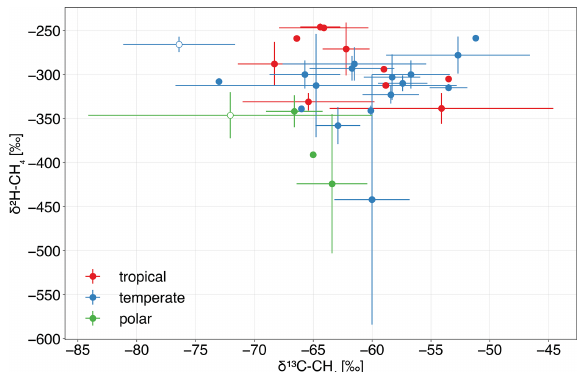
and δ 2 H CH signatures from wet- Figure A2. Measured δ 13 C CH 4 4 lands sites as reported in the literature (Beck et al., 2012; Burke and Sackett, 1986; Day et al., 2015; Happell et al., 1994; Kuhlmann et al., 1998; Lansdown, 1992; Levin et al., 1993; Martens et al., 1992; Nakagawa et al., 2002; Smith et al., 2000; Sugimoto and Fu- jita, 2006; Umezawa et al., 2011; Wahlen et al., 1989; Wassmann et al., 1992; Woltemate et al., 1984) (solid circled) and EMID (open circles) database, colour-coded by the latitude zones. Error bars show the standard deviations.